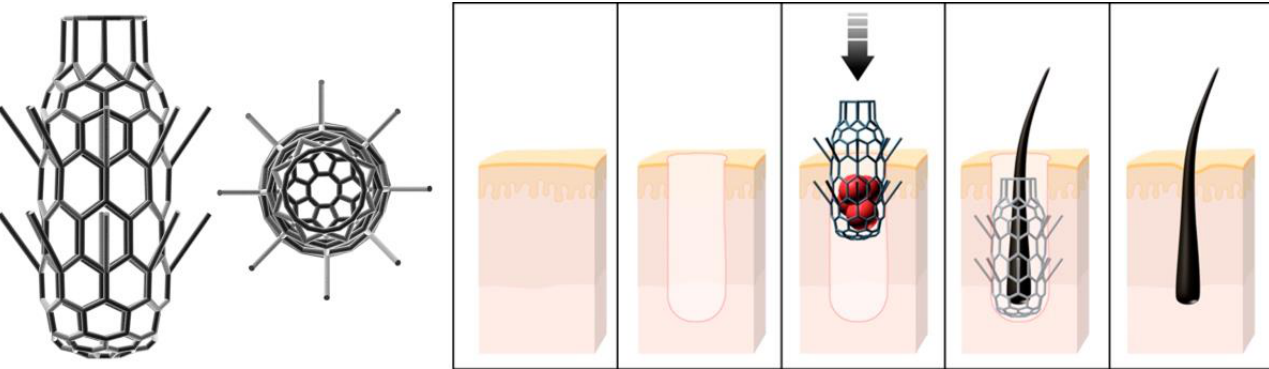
Figure 2. Design of mini-scaffold (“capillinser”) and scheme of sequential steps of robotic in situ bioprinting of tissue-engineered human hairs in the human skin using a specially designed mini-scaffold (“capillinser’).